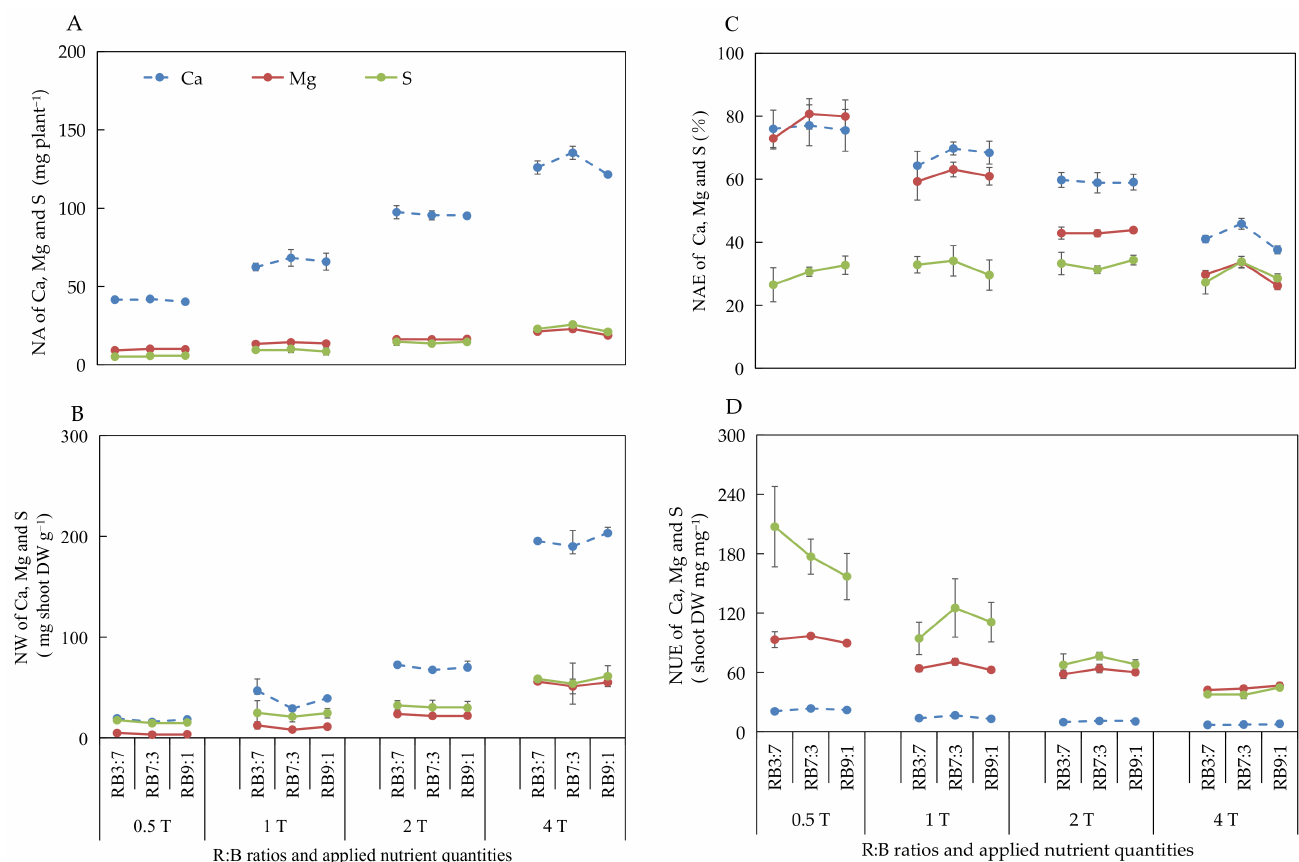
Figure 6. Nutrient absorption (NA) ( A ), nutrient waste (NW) ( B ) from producing 1 g shoot dry weight, nutrient absorb efficiency (NAE) ( C ), and nutrient use efficiency (NUE) ( D ) of shoot dry weight of Ca, Mg, and S after 20 days of cultivation under different ANQ treatments and R:B ratios. 0.5T, 1T, 2T, and 4T represent 4 different ANQ treatments. RB3:7, RB7:3, and RB9:1 represent the R:B ratios of 7:3, 3:7, and 9:1, respectively. The error bars represent SEs (n =